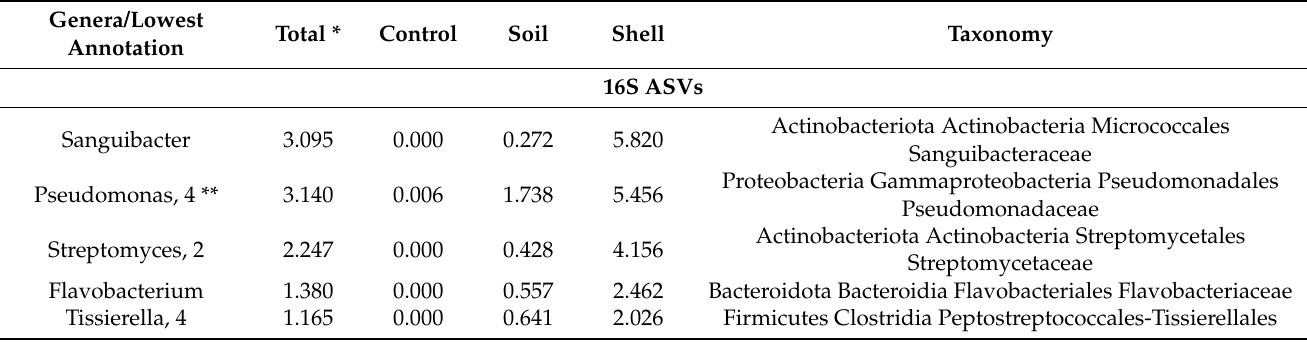
Table 1. 16S rRNA and ITS ASVs with potential to be directly involved in shell